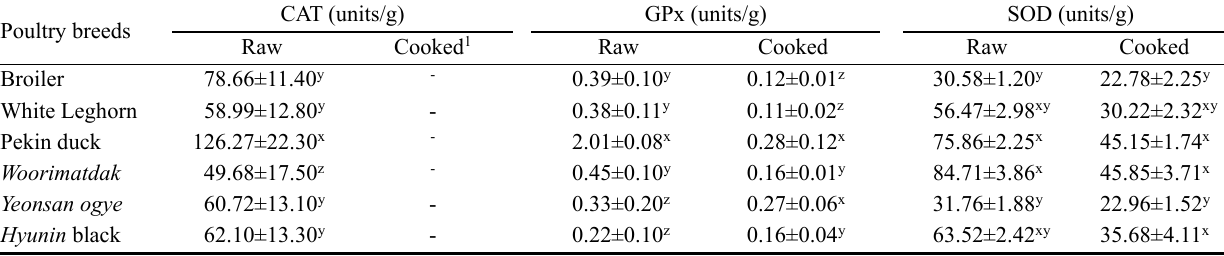
Table 1. Antioxidant enzyme activity of raw and cooked breast meat from different breeds of poultry Poultry